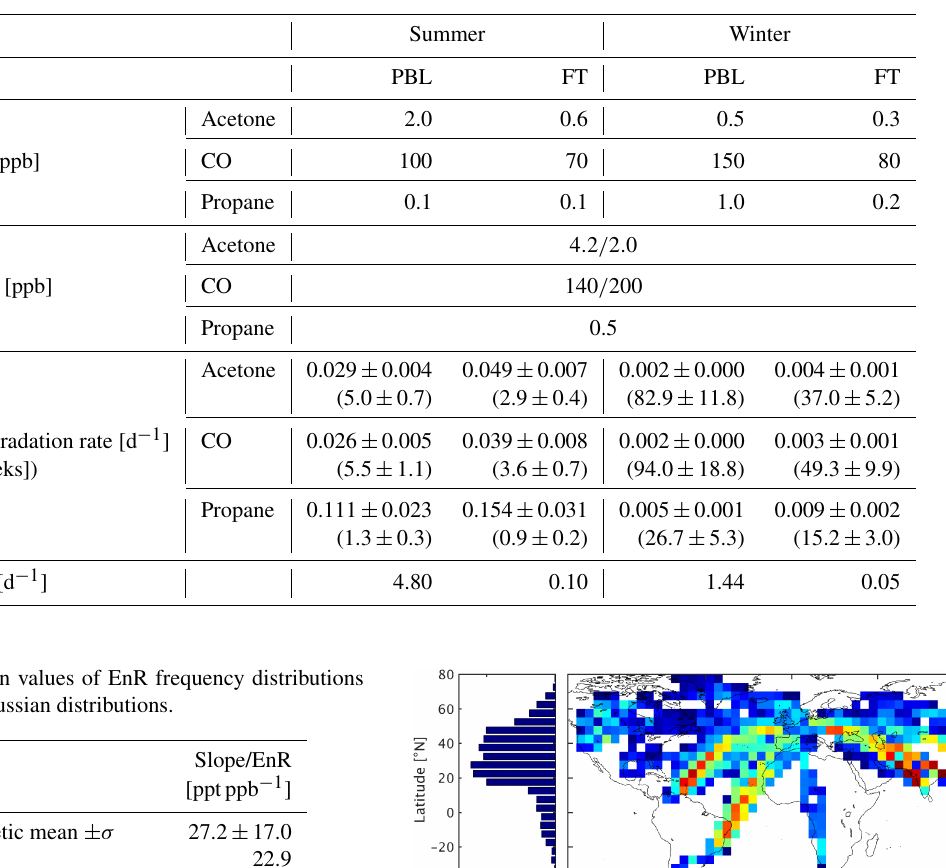
Table 5. Mixing ratios, chemical loss and dilution rates used for the simulation of the temporal evolution of acetone–CO EnRs shown in Fig. 4.